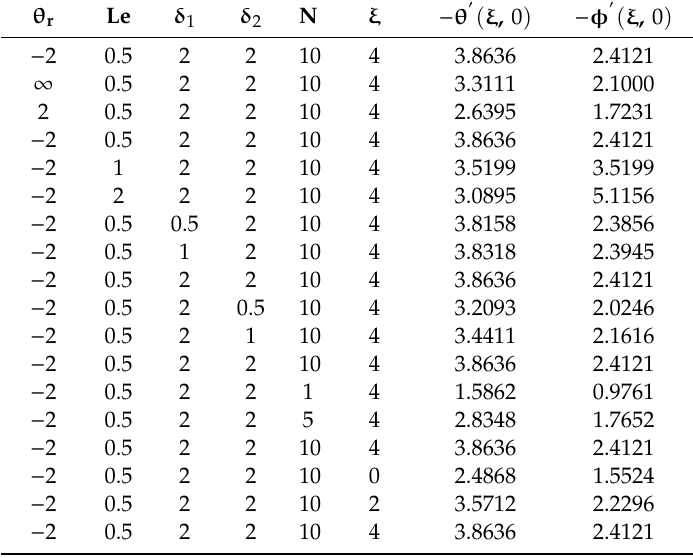
Table 7. Values of the local Nusselt number and the local Sherwood number for θ r , Le, δ 1 , δ 2 , N, ξ